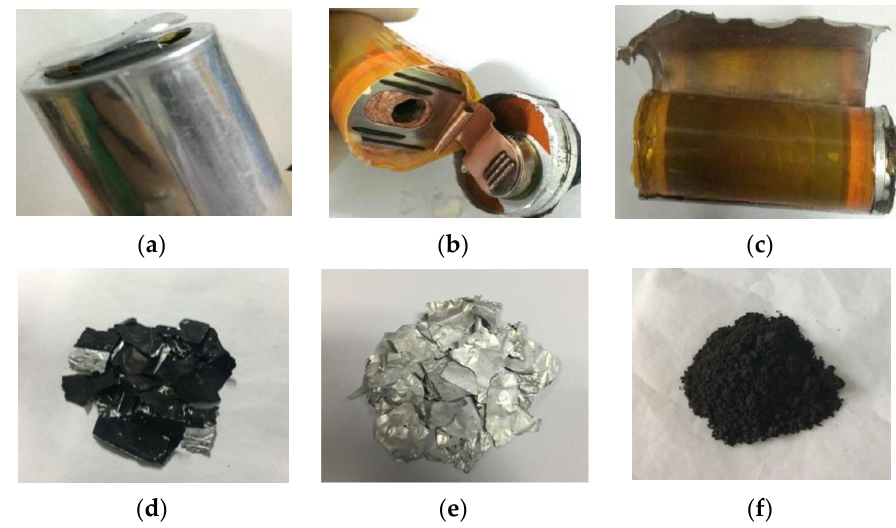
Figure 1. Spent power LIB: ( a ) battery unit, ( b ) battery cover opened, ( c ) shell pull out, ( d ) cathode plate, ( e ) aluminum foil, and ( f ) cathode active material.